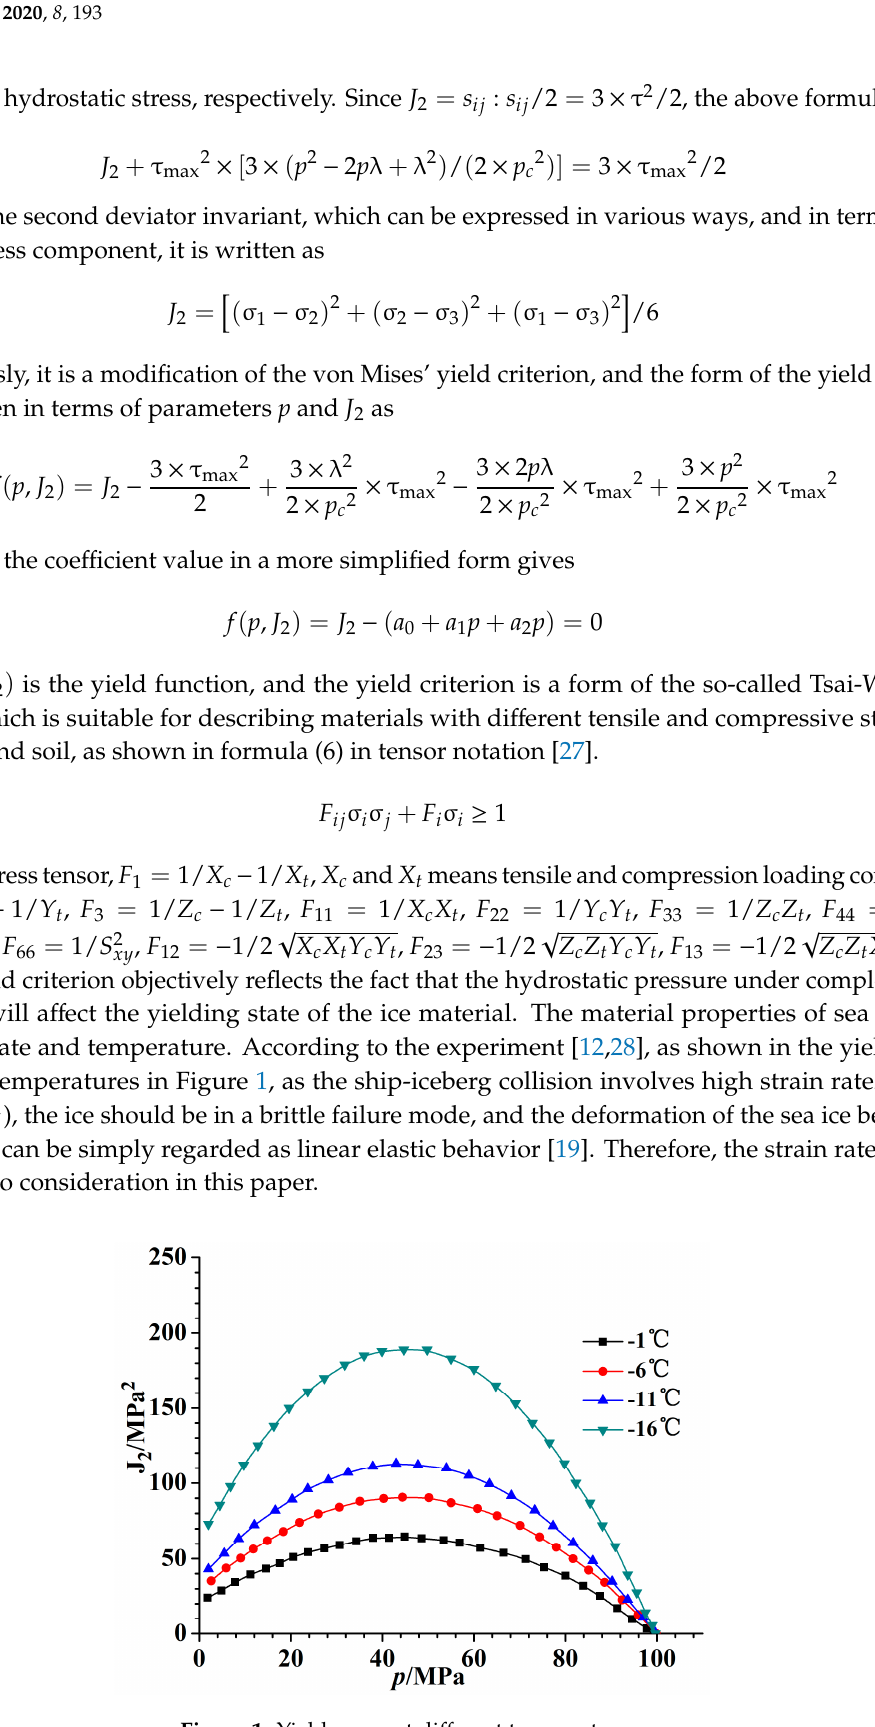
Figure 1. Yield curve at different temperatures.